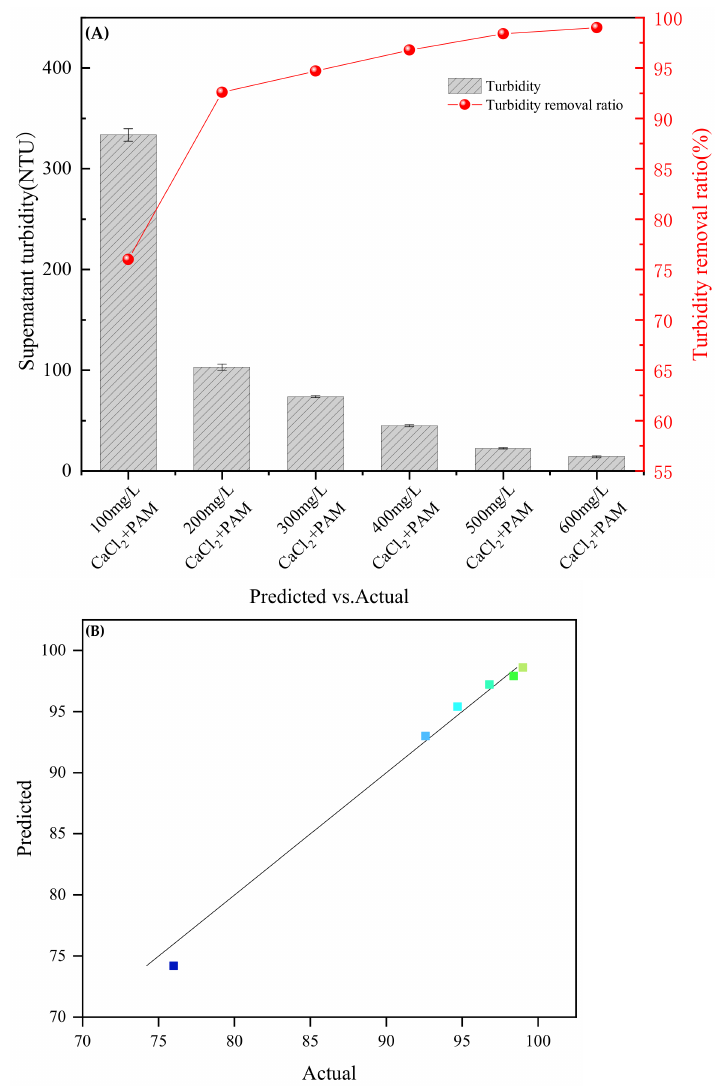
Figure 6. ( A ) Influence of CaCl 2 dosage on turbidity removal. ( B ) Predicted vs. actual values plot for the turbidity removal